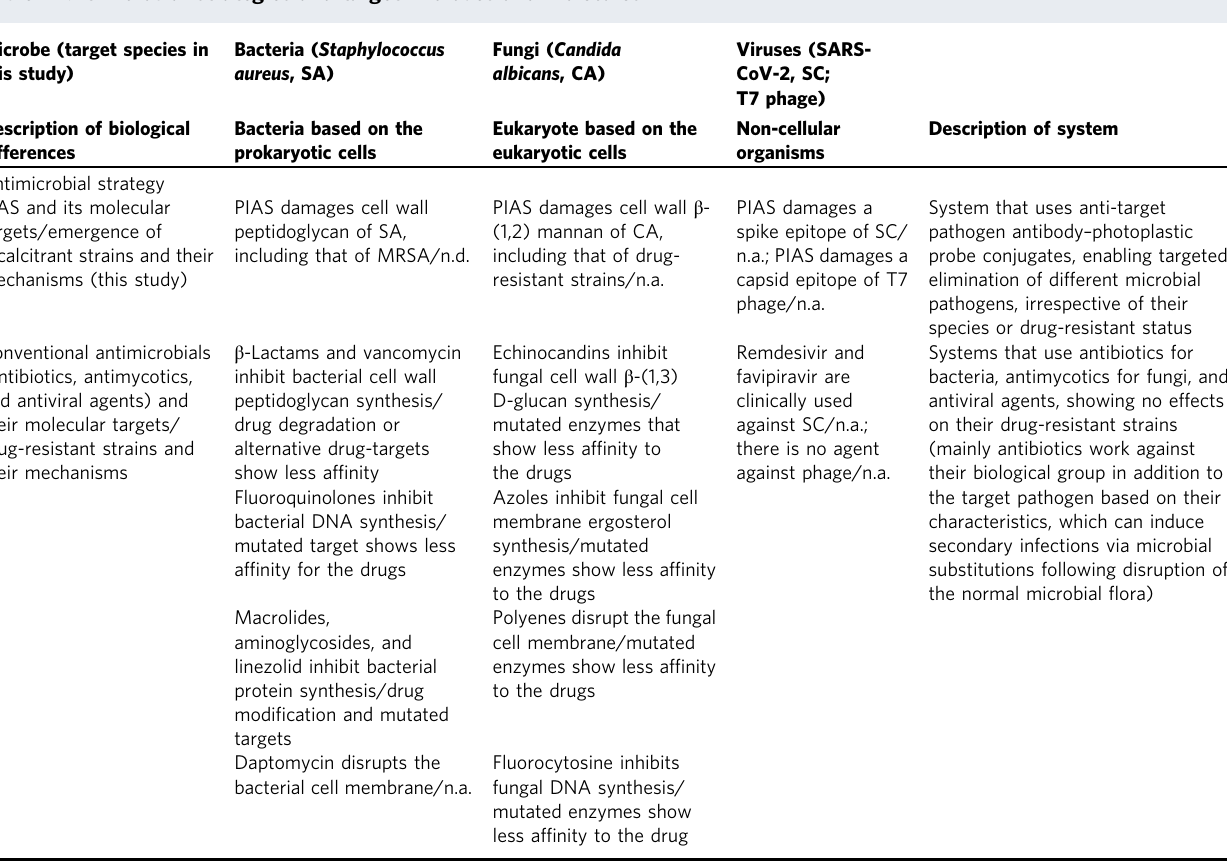
Table 1 Antimicrobial strategies and target microbes and molecules.